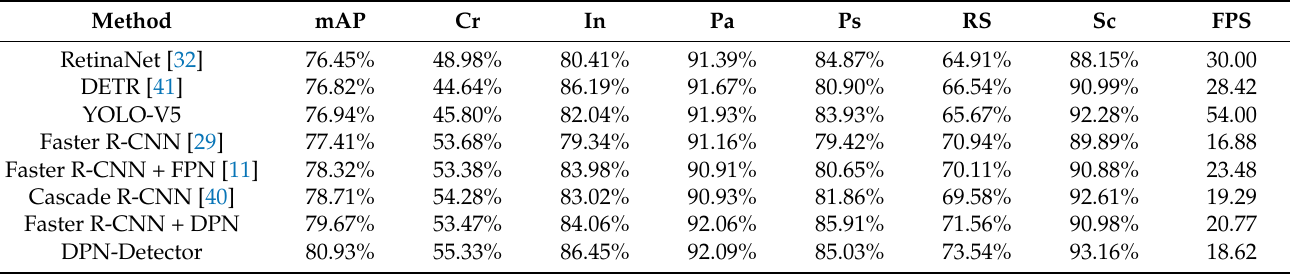
Table 3. Defect detection results on